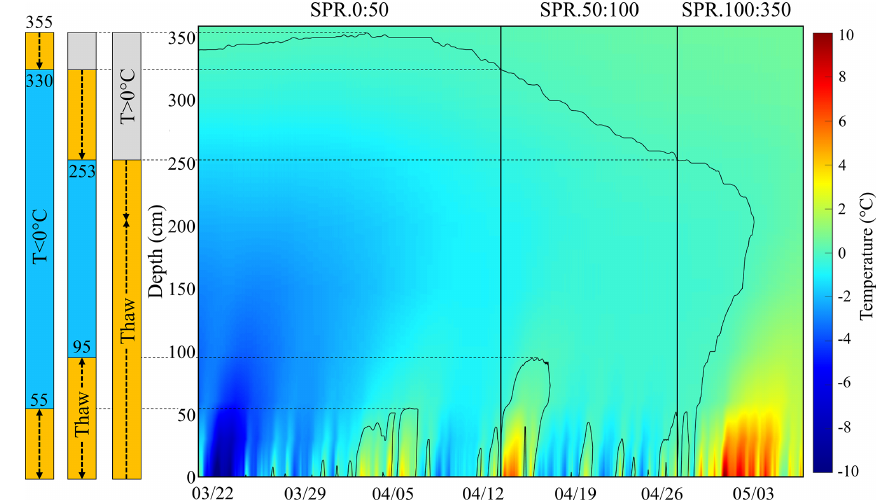
Figure 7. Rock temperature evolution along a perpendicular profile from the surface to 360cm depth, 21 March–6 May 2020. Dark time series are for freeze–thaw depth (0 ◦ C). Vertical lines delimit scan periods.